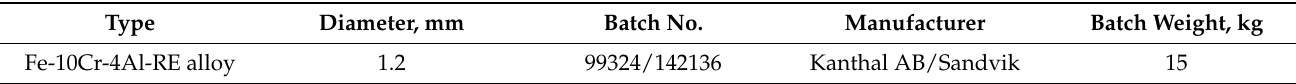
Table 2. Information of the weld wire.